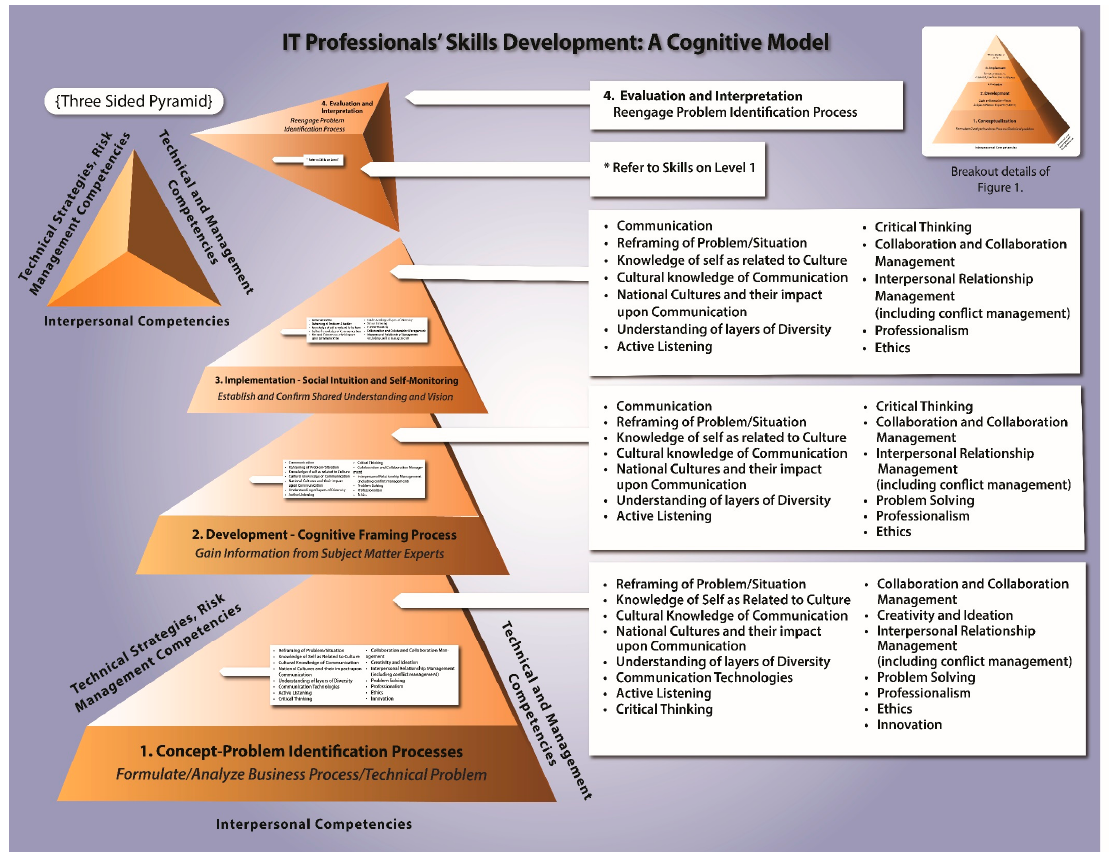
Figure 6. Non-technical Skills Model Integrated into a Simulated IT Project through the entire Systems Development Life Cycle. Table 5. Typology of non-technical skills for necessary for step 3 implementation—social intuition and self-monitoring.